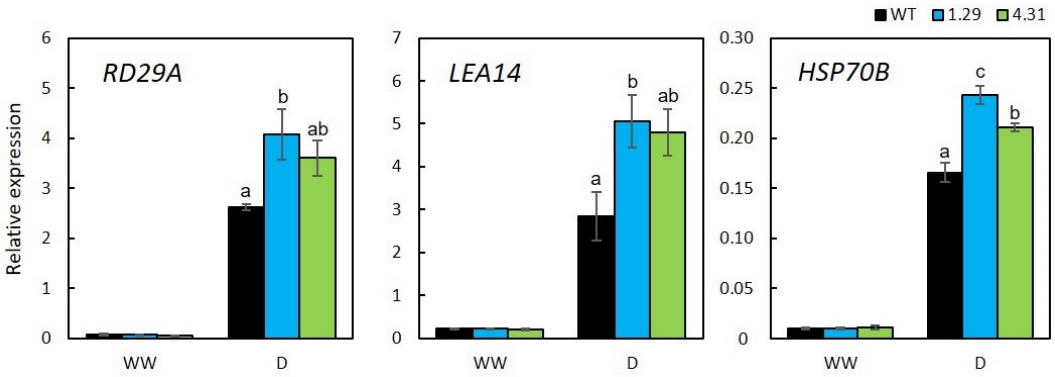
Figure 4. Relative expression of drought-responsive genes AtRD29A , AtLEA14 and AtHSP70B under well-watered (WW) and 10-day-drought (D) conditions in wild-type (WT) and transgenic plants ectopically expressing GmRR34 (independent lines 1.29 and 4.31). Three biological replicates were used for each genotype under the same treatment, and statistically identified differences among them were indicated by different letters ( p -value < 0.05). Error bars indicate standard errors.